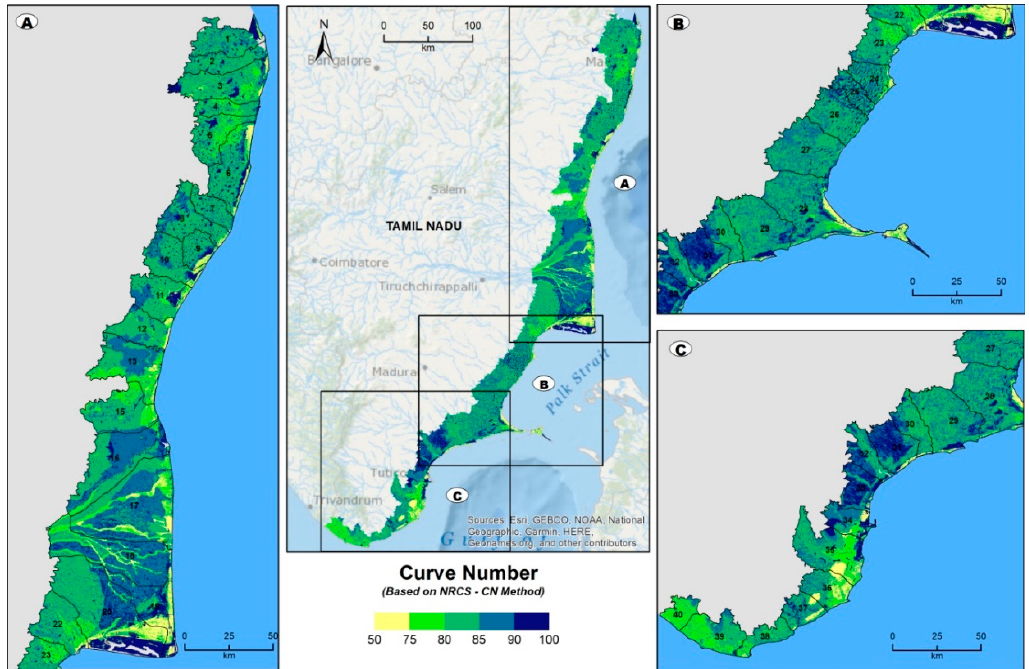
Figure 5. Surface runoff potential in the coastal plains of Tamil Nadu. The higher values of curve number denote more surface runoff potential. The spatial distributions of curve number in the northern, central, and southern parts of the study area are represented in inset figures ( A – C ), respectively. A very low runoff potential is noted wherever beaches and sand bars are